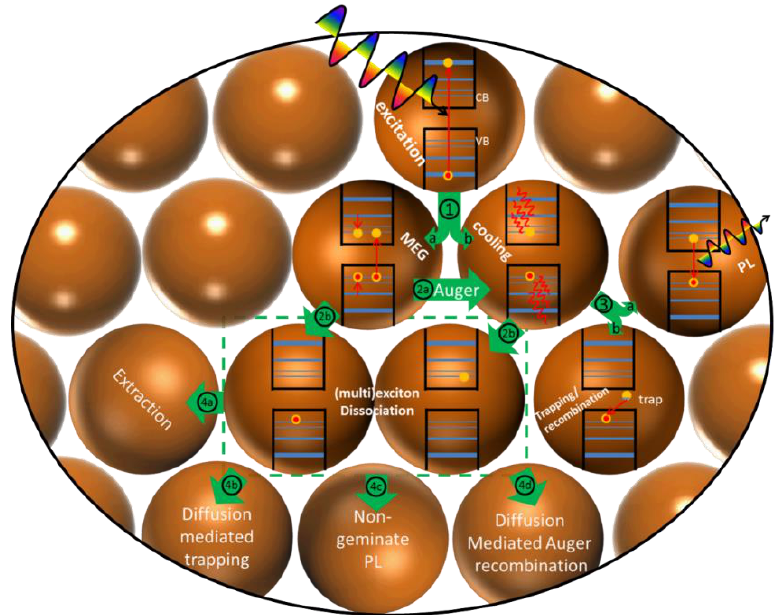
Figure 3. Schematic representations of the different steps in creating free charges in QD films. Green arrows are the different pathways the excitation can take, red arrows represent energy changes either phonon emission, photoluminescence, or Auger/inverse Auger energy transfer, blue lines represent the quantized states in the potential well (black lines) of the QDs (brown spheres), yellow dots are electrons and yellow circles with red dots are holes.